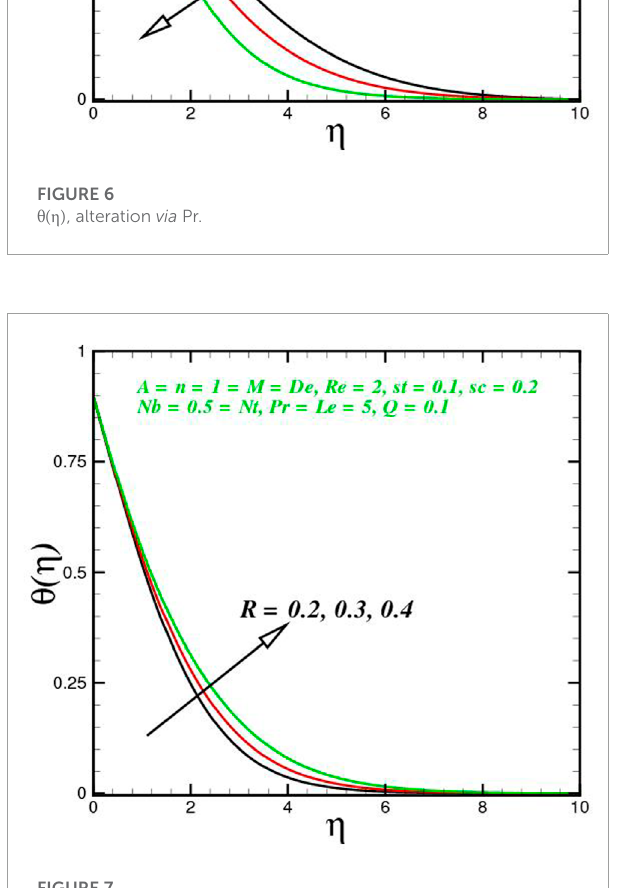
FIGURE 9 θ ( η ) , alteration via S t